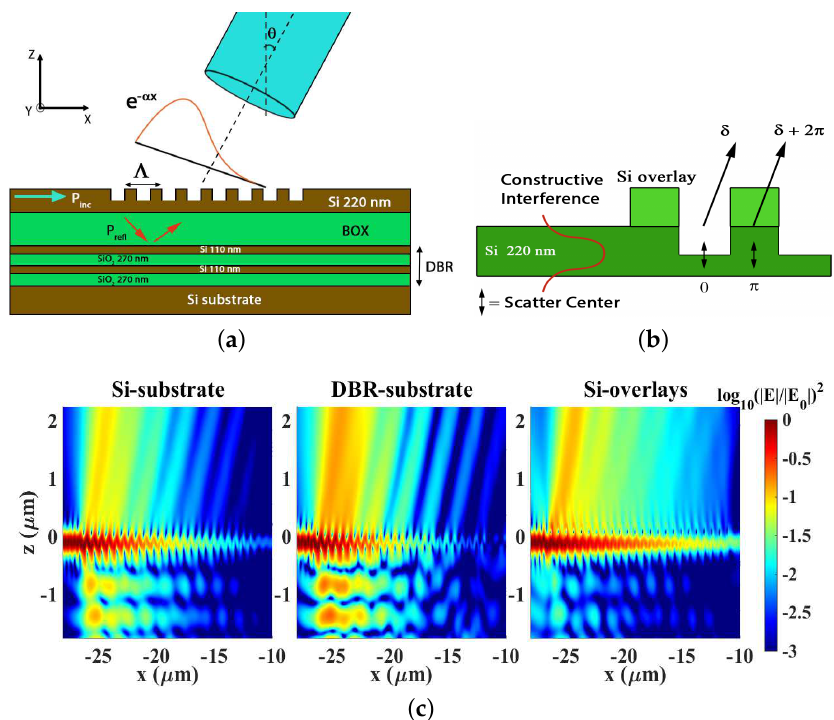
Figure 4. Two prominent means of suppressing substrate leakage ( a ) surface gratings with a distributed Bragg reflector (DBR) composed of alternating layers of Si / SiO 2 and ( b ) with overlay gratings. In ( c ), the diffracted electric field intensity profile in log scale is plotted from 2-D FDTD simulations, in which the grating coupler is excited from fundamental mode in slab waveguide, in the three cases of Si -substrate, DBR substrate and Si